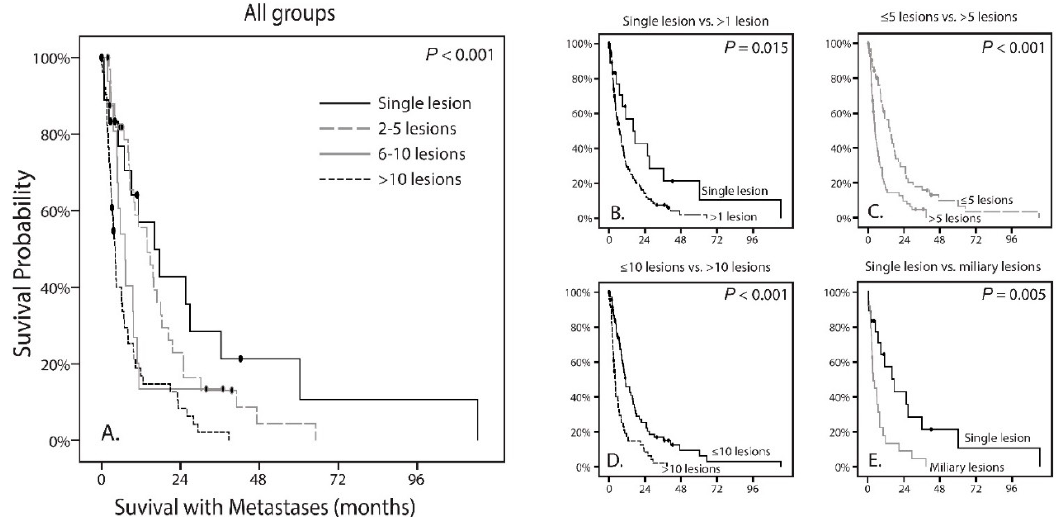
Figure 3. Kaplan-Meier curves showing the survival with metastases of the four classified tumor profiles as well as of multiple comparisons; ( A ) The survival differs significantly between the groups ( p < 0.001); ( B ) The survival is significantly more favorable in patients who have a single hepatic lesion compared to patients with more than one lesion ( p = 0.015); ( C ) The survival is significantly more favorable in patients who have less than five hepatic lesion compared to patients with more than five lesion ( p < 0.001); ( D ) The survival is significantly more favorable in patients who have less than 10 hepatic lesion compared to patients with more than 10 lesion ( p < 0.001); ( E ) Comparison of patients with a single hepatic lesion with patients who have a miliary hepatic metastatic pattern reveals a worse DFS in the miliary group ( p = 0.005). Following, we analyzed whether the number of metastases in the liver were correlated to the survival with metastases. A difference was observed when comparing